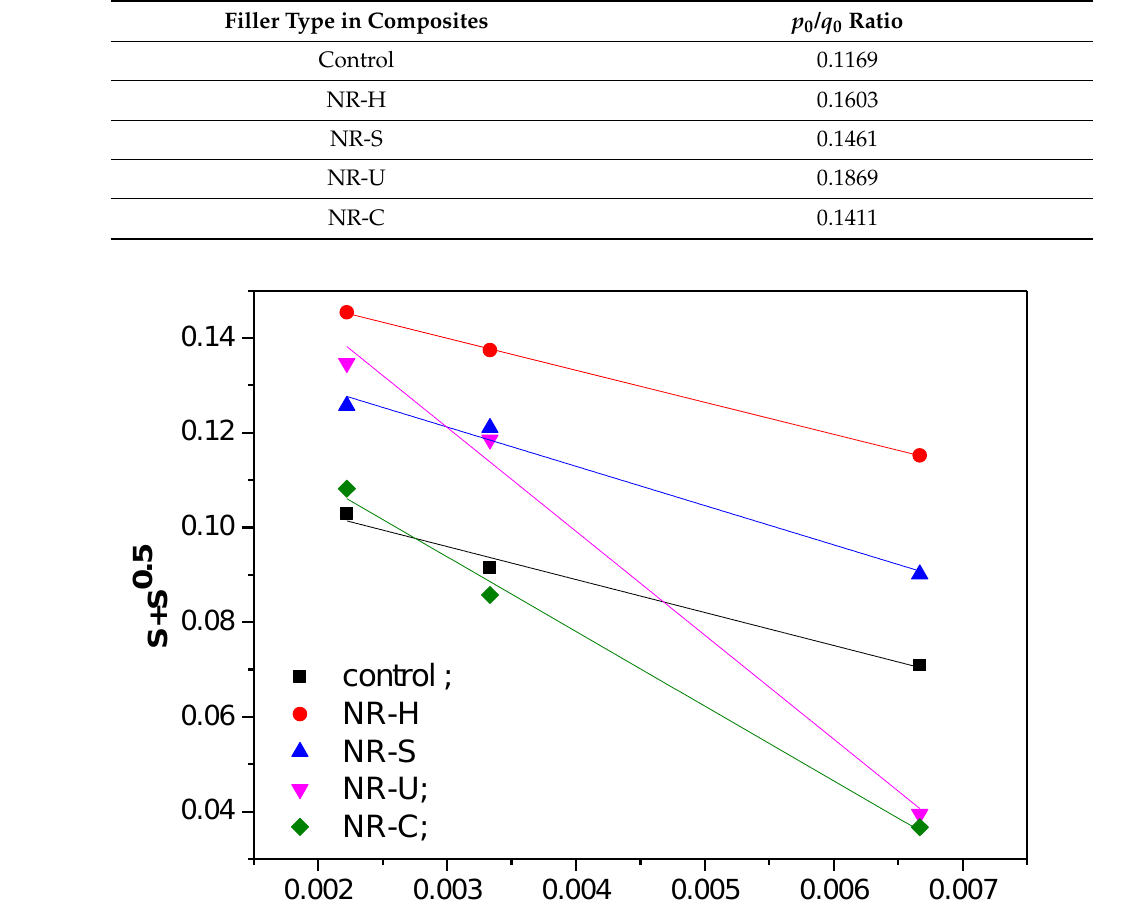
Table 6. p 0 / q 0 ratio for composites.